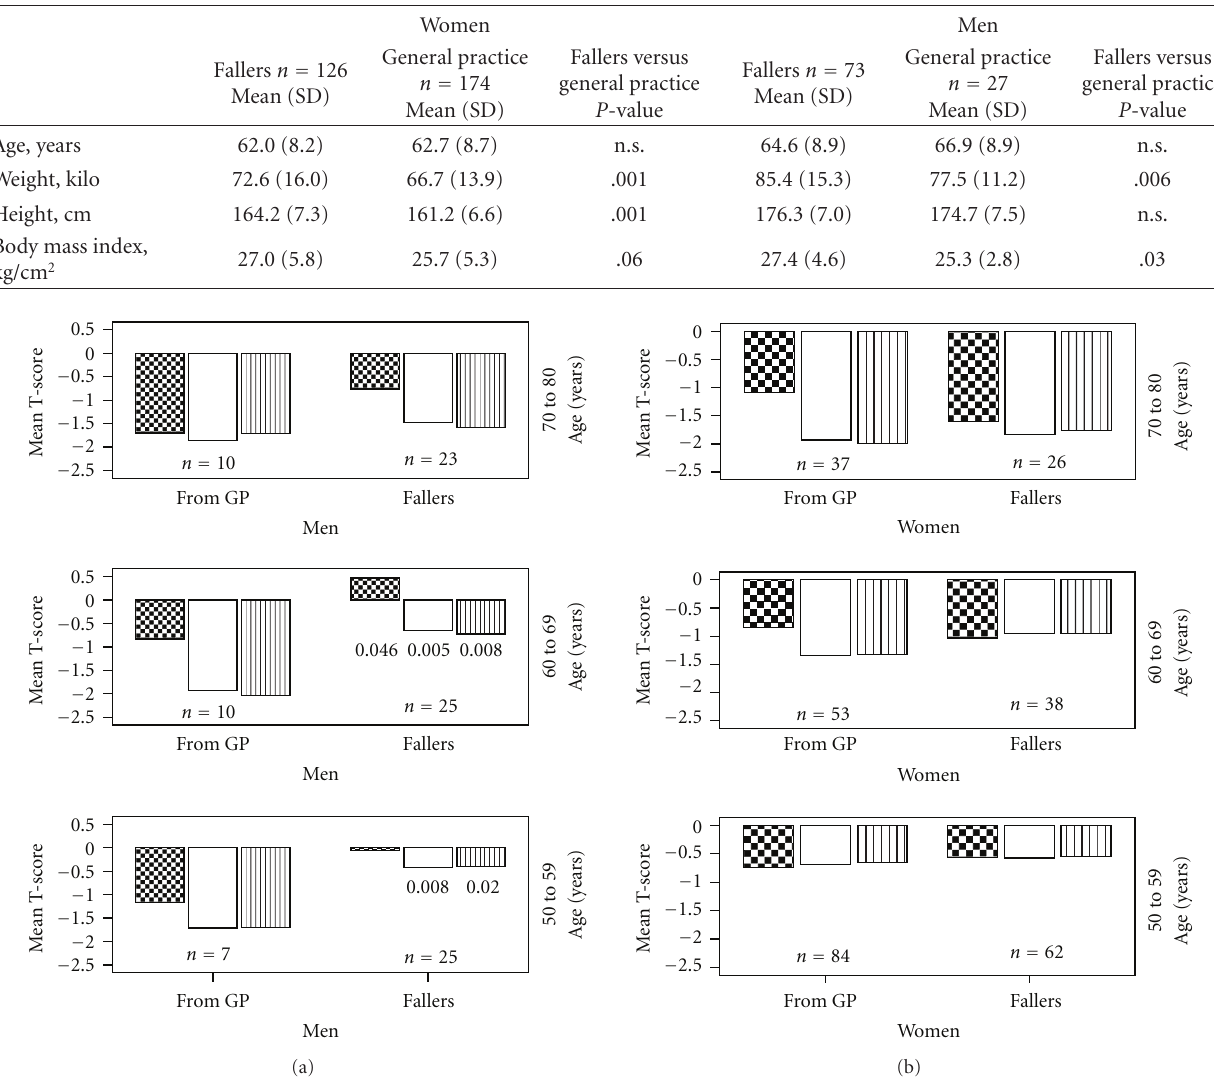
Table 2: Demographic data on fallers included from emergency department ( n = 199) compared to patients referred from general practice ( n = 201). Data on women and men are reported separately. Results from independent sample t -test.